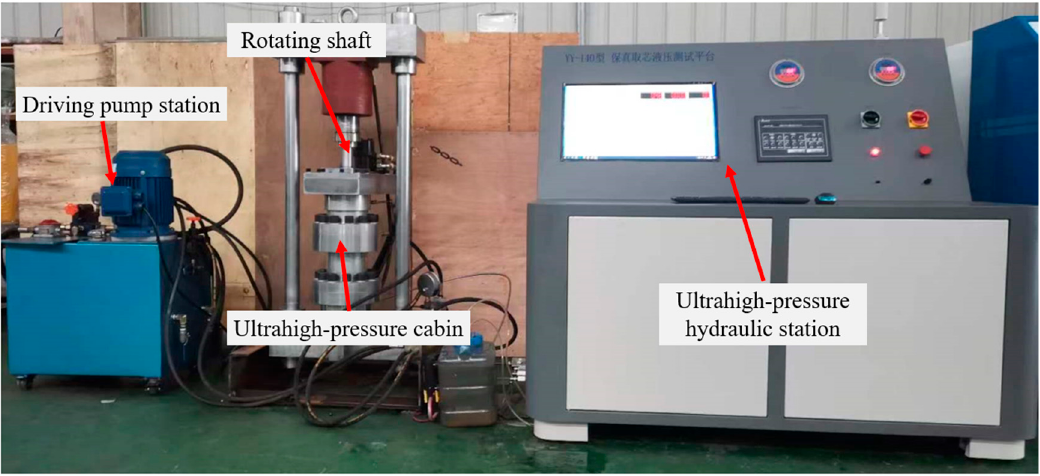
Figure 14. Ultrahigh-pressure dynamic system experimental equipment.